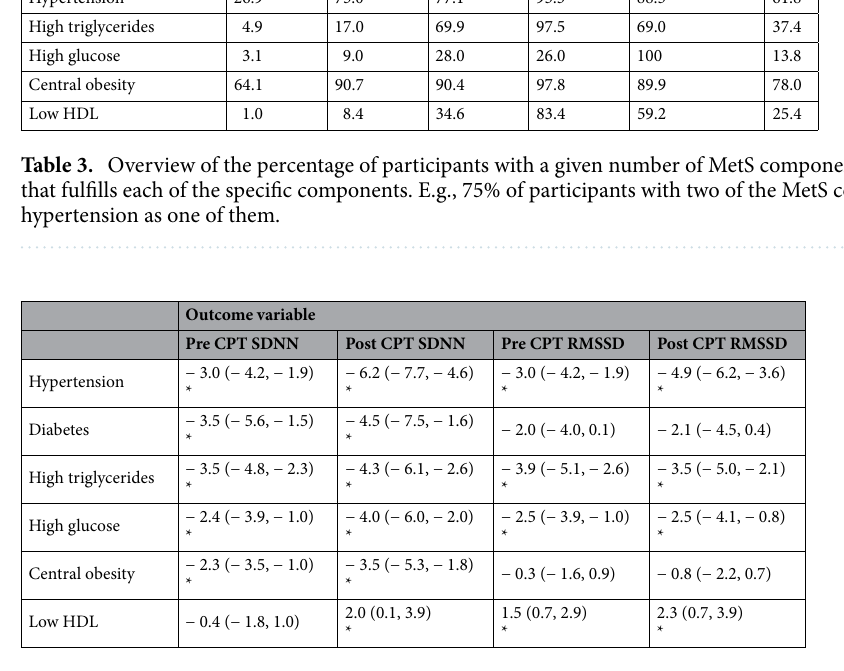
Table 4. Estimate (95% confidence interval) and p-value of each MetS component for every PRV outcome. The estimates are the mean change in PRV when specific MetS components are acquired, when the other variables are kept constant. MetS metabolic syndrome, CPT cold pressure test. * p < 0.05.